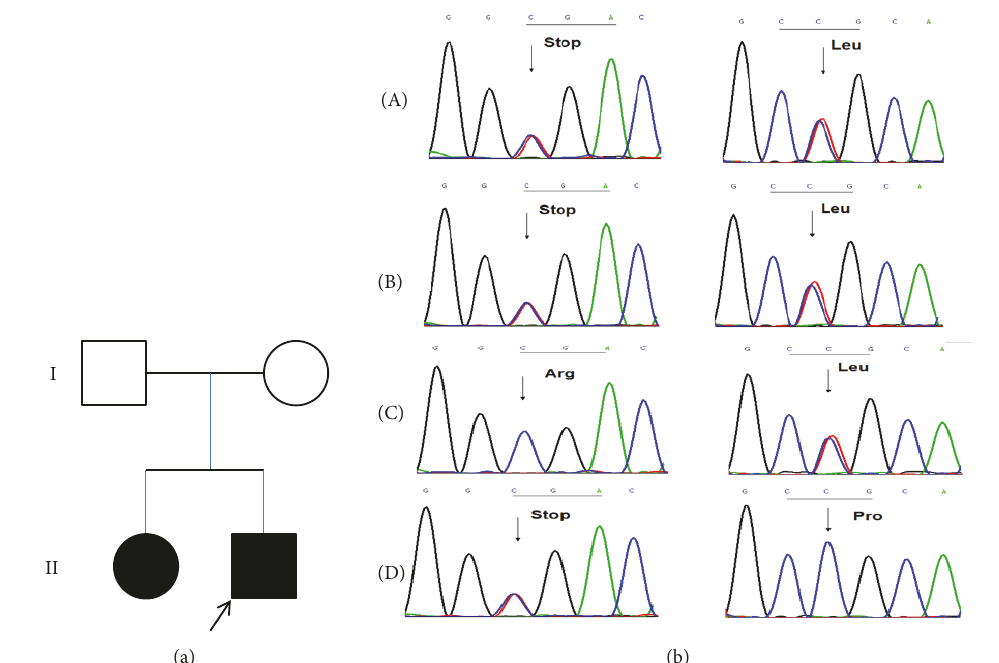
Figure 1: (a) Pedigree of family and (b) Sanger sequencing results from TRAPPC11 mutations. The left column shows the c.1192C > T (p.Arg398 ∗ ) mutation and the right column shows the c.3014C > T (p.Pro1005Leu) mutation. The two firsts row ((A) and (B)) shows results from the children. The next rows ((C) and (D)) show the results from the parents.